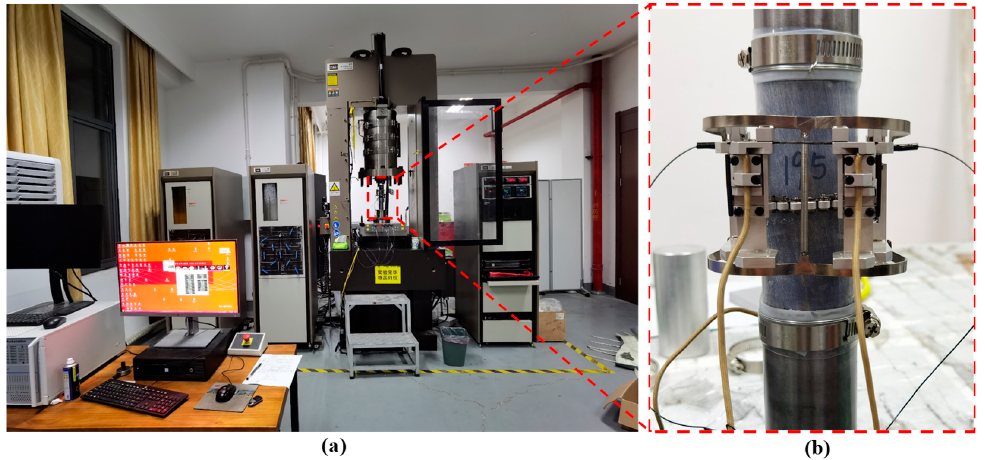
Figure 1. ( a ) Servo-controlled rock mechanics testing system (MTS 815.04) with high pressure ( b ) sealed specimen and radial deformation monitoring device.